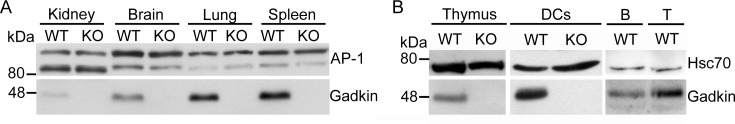
Gadkin is expressed in lymphoid organs and in immune cells.A. Lysates of WT and Gadkin-/- (labeled as KO) tissues were analyzed by immunoblotting using Gadkin- and AP-1-specific antibodies. B. Lysates of WT and Gadkin-/- thymus, of DCs derived from WT and Gadkin-/- bone marrow, as well as of B lymphocytes (i.e. B220-positive B cells) and T lymphocytes (i.e. CD3-positive T cells) isolated from spleen were analyzed by immunoblotting using Gadkin-specific antibodies. Detection of the constitutively expressed molecular chaperone heat shock cognate protein 70 (Hsc70) was used as loading control. B, B-lymphocytes; T, T-lymphocytes.